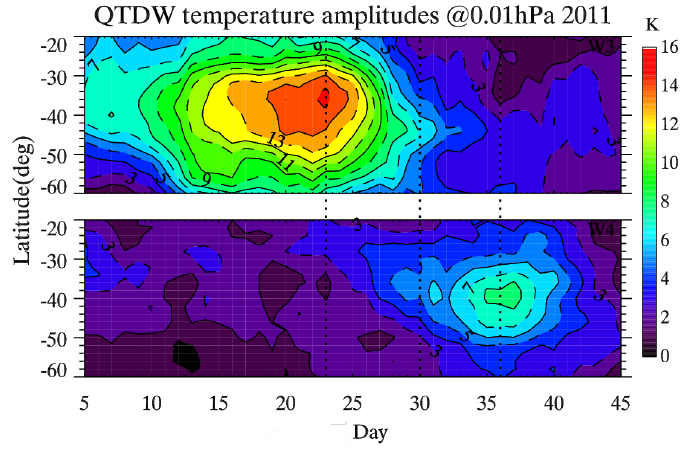
Figure 2. Temporal variations of W3 ( top ) and W4 ( bottom ) at 0.01 hPa during days 5 − 45 in 2011. The contour interval is 1 K. The vertical dot lines at days 23 and day 36 indicate when W3 and W4 reached maximum amplitudes, while the dot line at day 30 indicates when W3 and W4 were nearly equally strong. It is also clear in Figure 2 that the amplitudes of W4 were first observed in